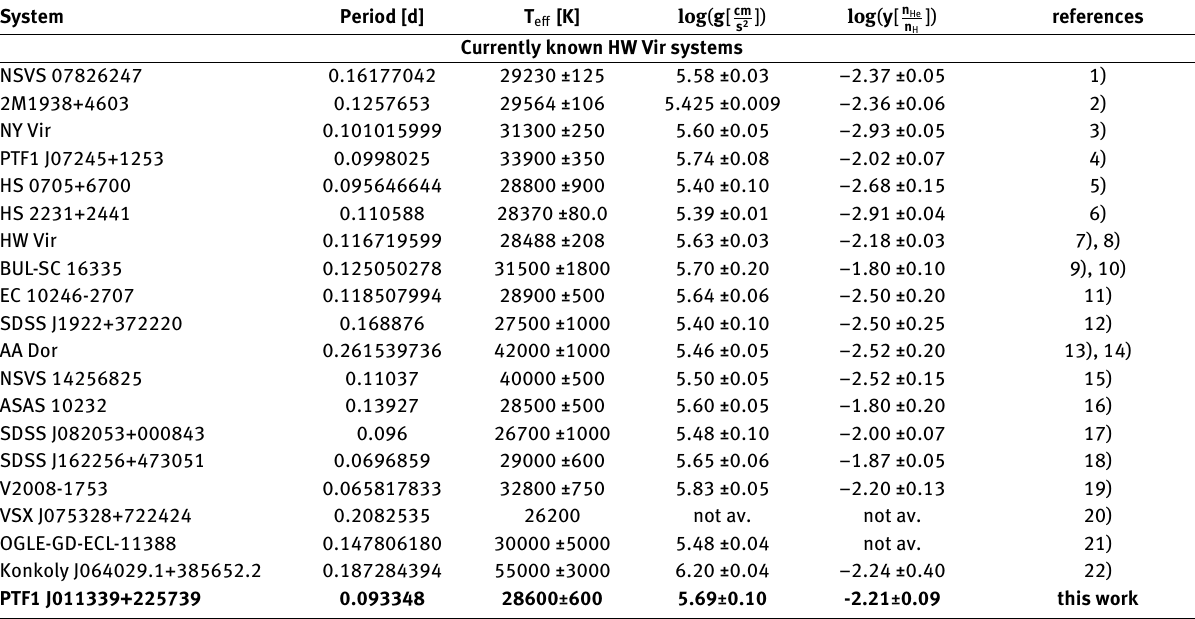
Table 5. Currently known, short-periodic, post common-envelope binaries (PCEBs) which consist of a sdB star and an M-dwarf (dM) or a brown dwarf (BD). Quoted uncertainties are of statistical nature, systematic errors are not